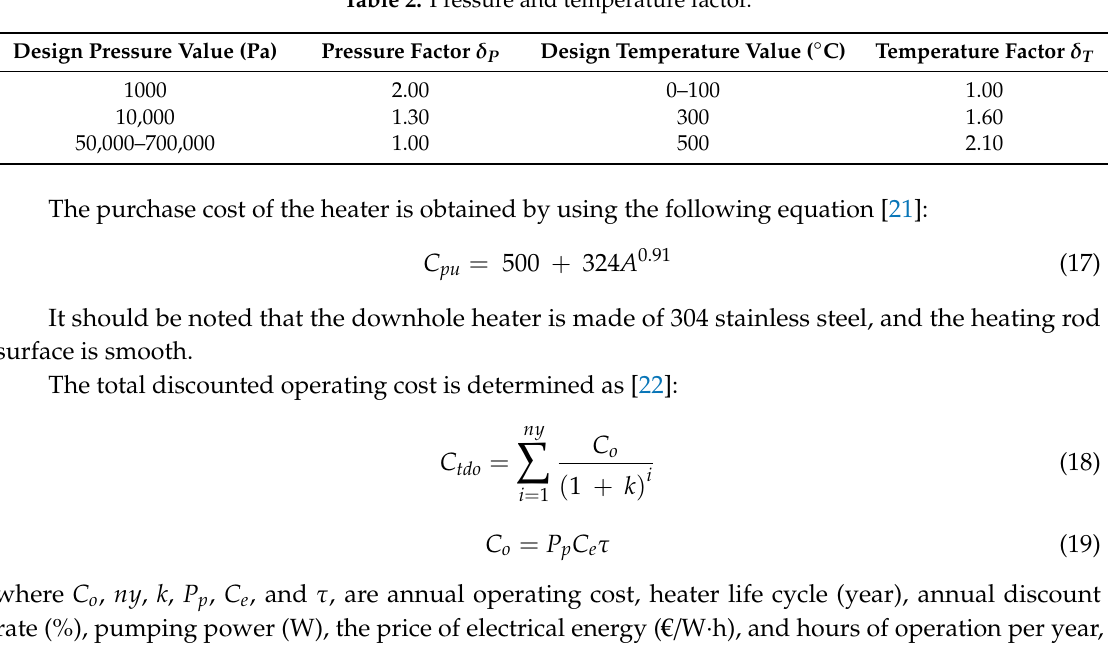
Table 2. Pressure and temperature